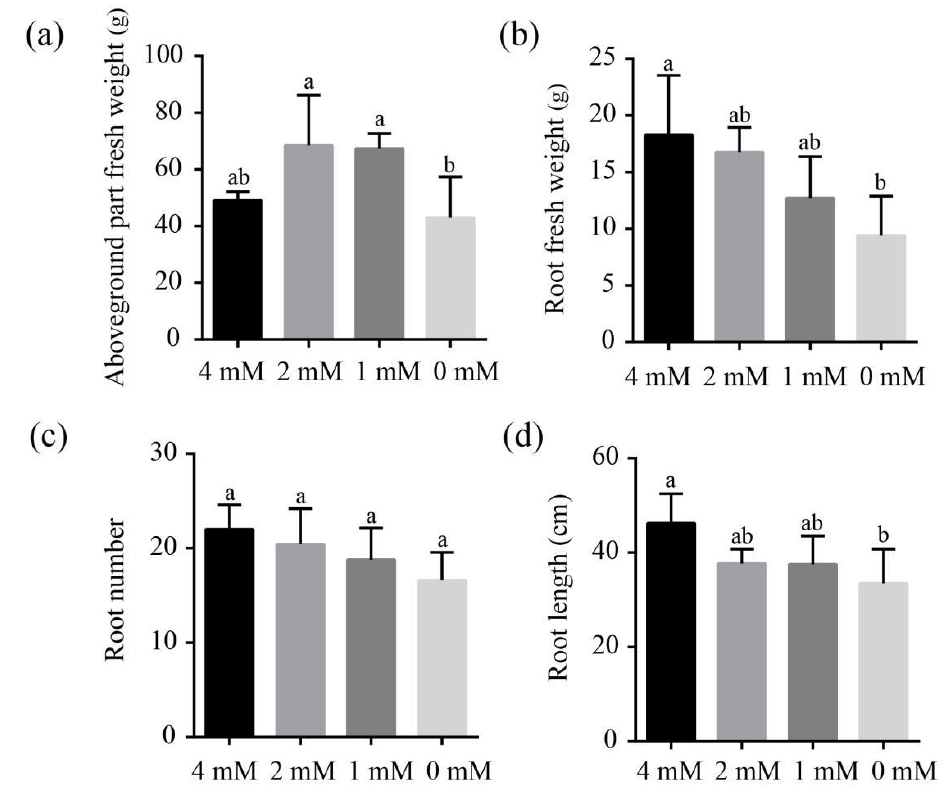
Figure 6. Effects of different concentrations of Ca 2+ treatments on the aboveground part fresh weight ( a ), root fresh weight ( b ), root number ( c ) and root length ( d ). All data are displayed as mean ± standard deviation (SD) of at least three replicates. Different lowercase letters above columns represent significant difference at p < 0.05.